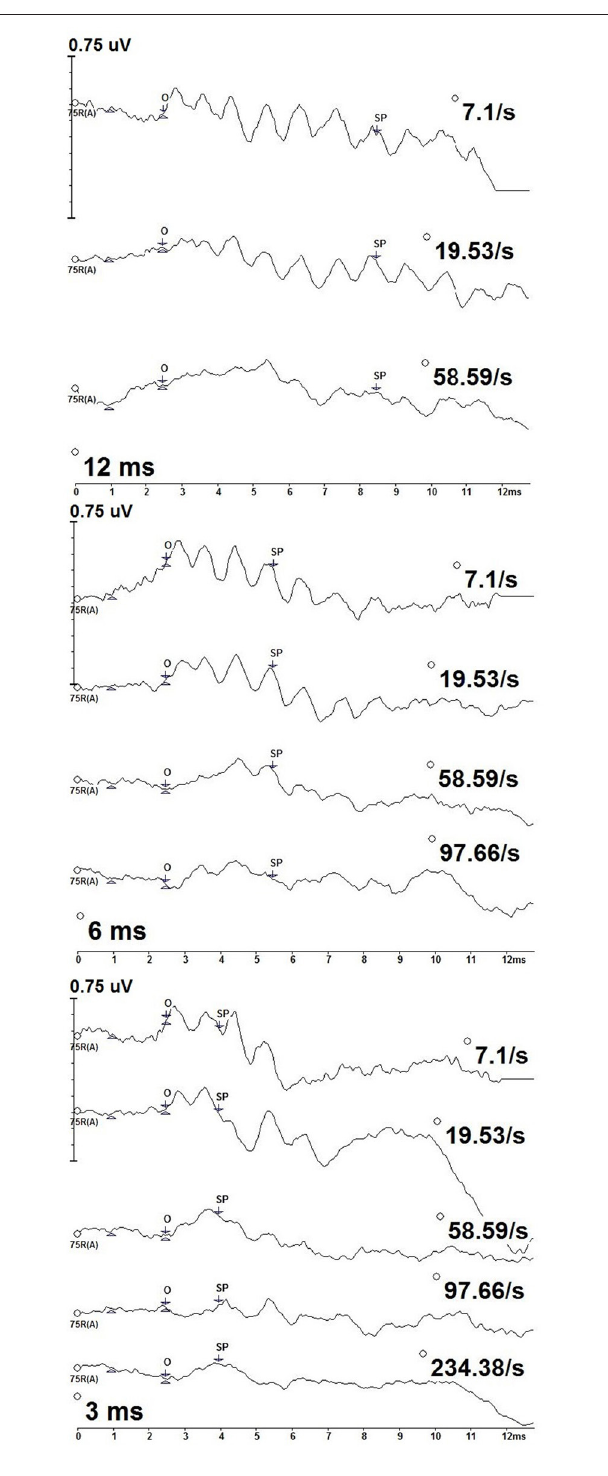
FIGURE 2 | CLAD deconvolved, 500 Hz tone burst ECochG measurements from one participant (P9) across stimulus duration (12 ms—top; 6 ms—middle; 3 ms—bottom). Responses to increasing repetition rate are displayed from top to bottom in each panel. SP amplitude was measured as the baseline at 1 ms to the SP waveform midpoint (SP). The SP waveform midpoint (SP) was measured from onset